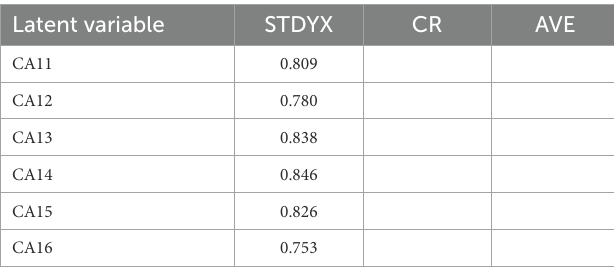
TABLE 2 Convergent validity and internal consistency